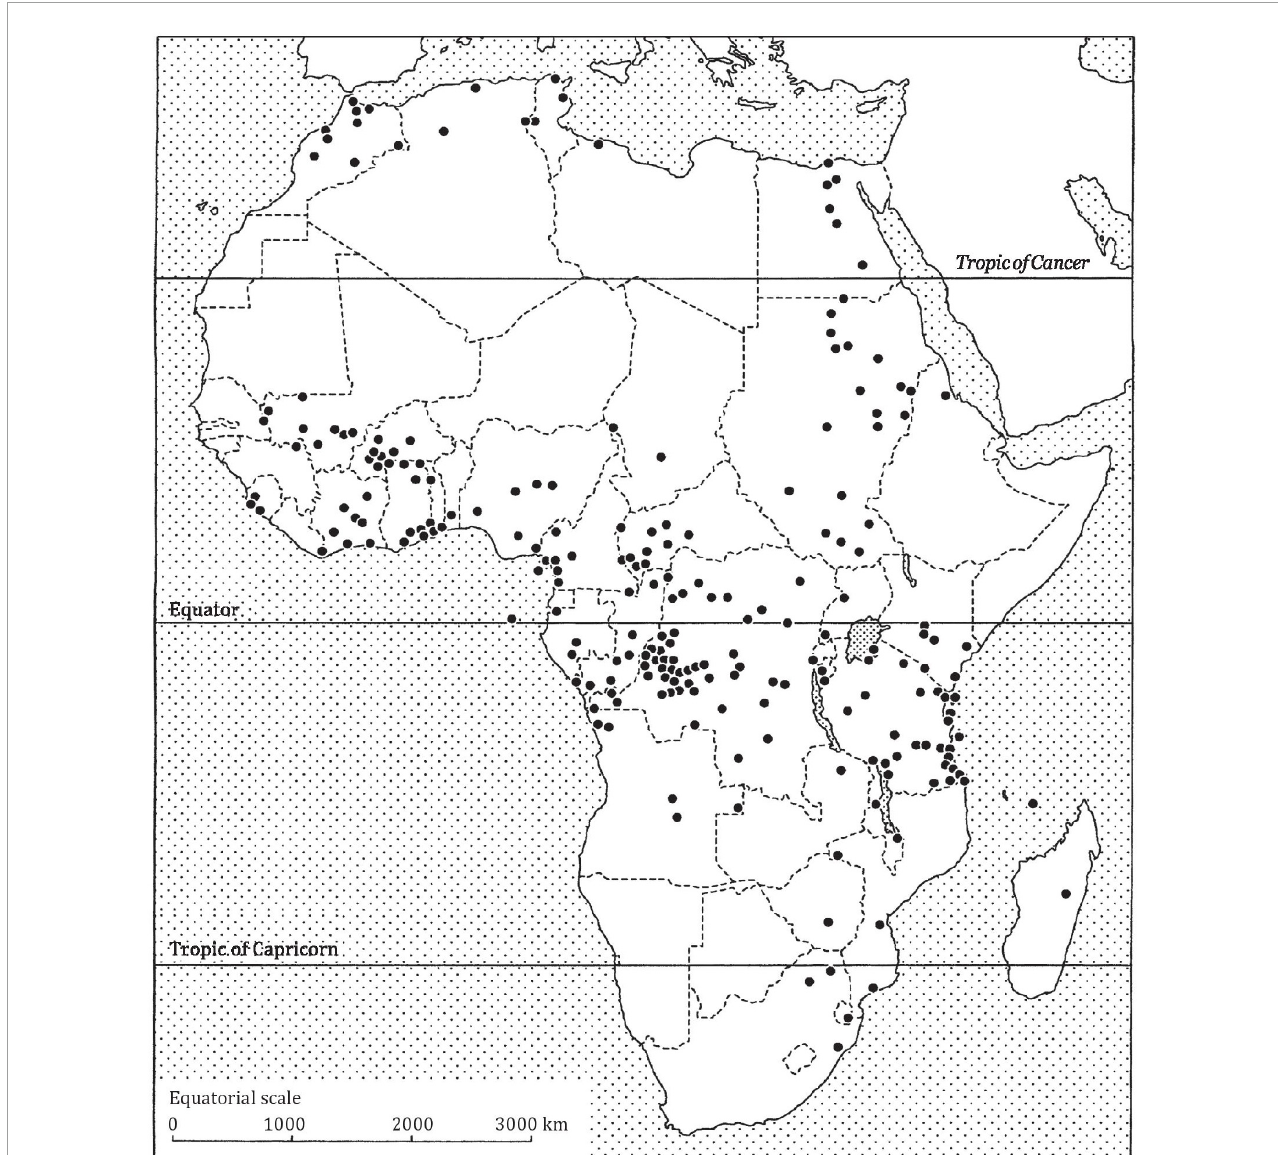
FIGURE1 The distribution of geophagy in Africa (shown by the dots) is widespread, though not all countries of the Continent (e.g., some countries in the Sahara) practice the phenomenon. Source: Compiled by Henry and Cring (5) from data by Anell and Lagercrantz (79) and Abrahams and Parsons